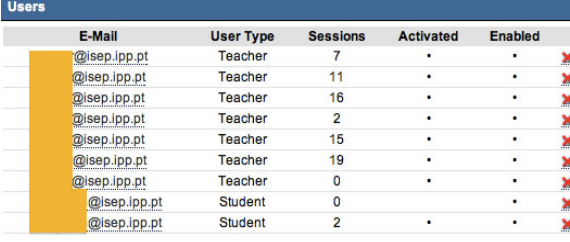
Figure 4. VISIR users tracking information